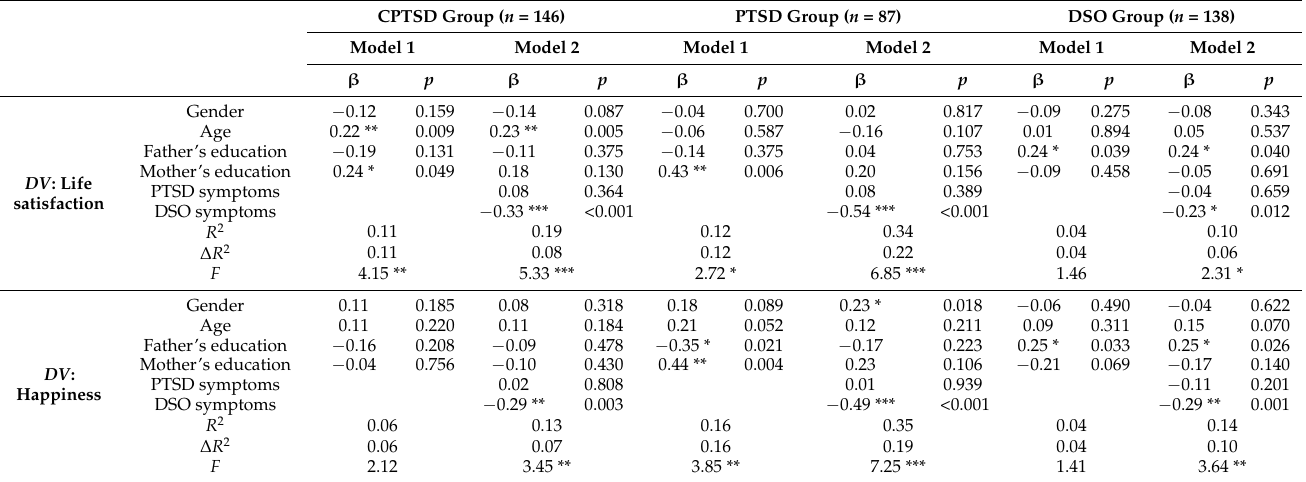
Table 6. Summary of hierarchical linear regression analysis for PTSD symptoms and DSO symptoms predicting hedonic well-being. CPTSD Group ( n =